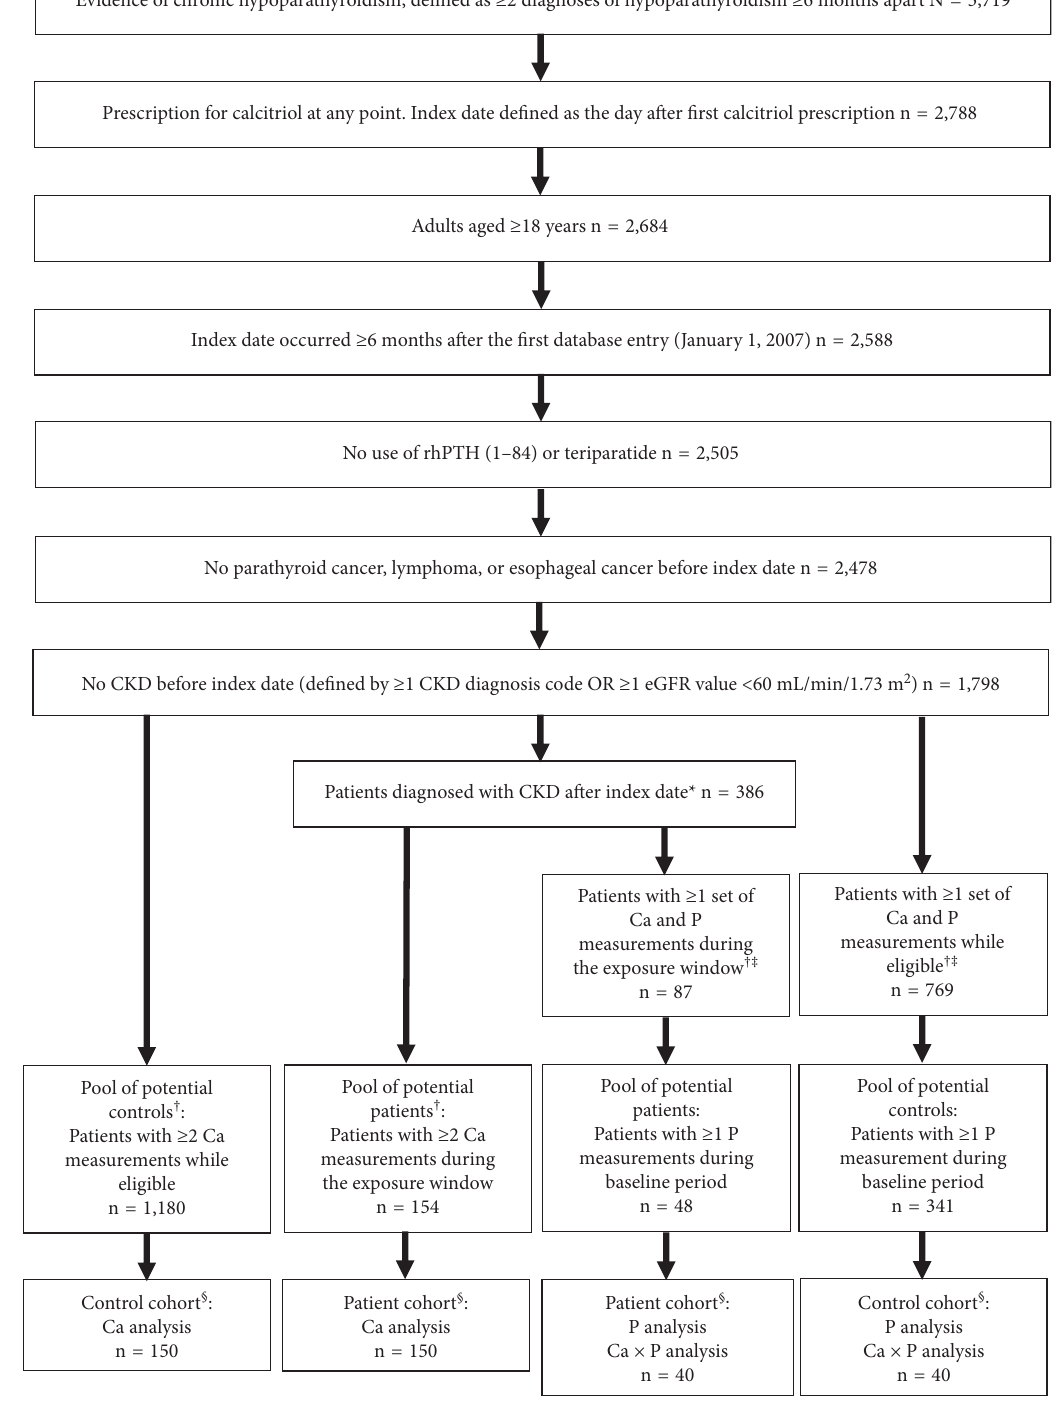
Figure 2: Selection of the study analysis cohorts. Ca: albumin-corrected serum calcium; Ca × P: calcium-phosphate product; CKD: chronic kidney disease; eGFR: estimated glomerular fltration rate; P: serum phosphate; rhPTH(1–84): recombinant human parathyroid hormone (1–84). ∗ Patients with CKD must have had a diagnosis of CKD after the index date to be eligible. Patients with a diagnosis of CKD before